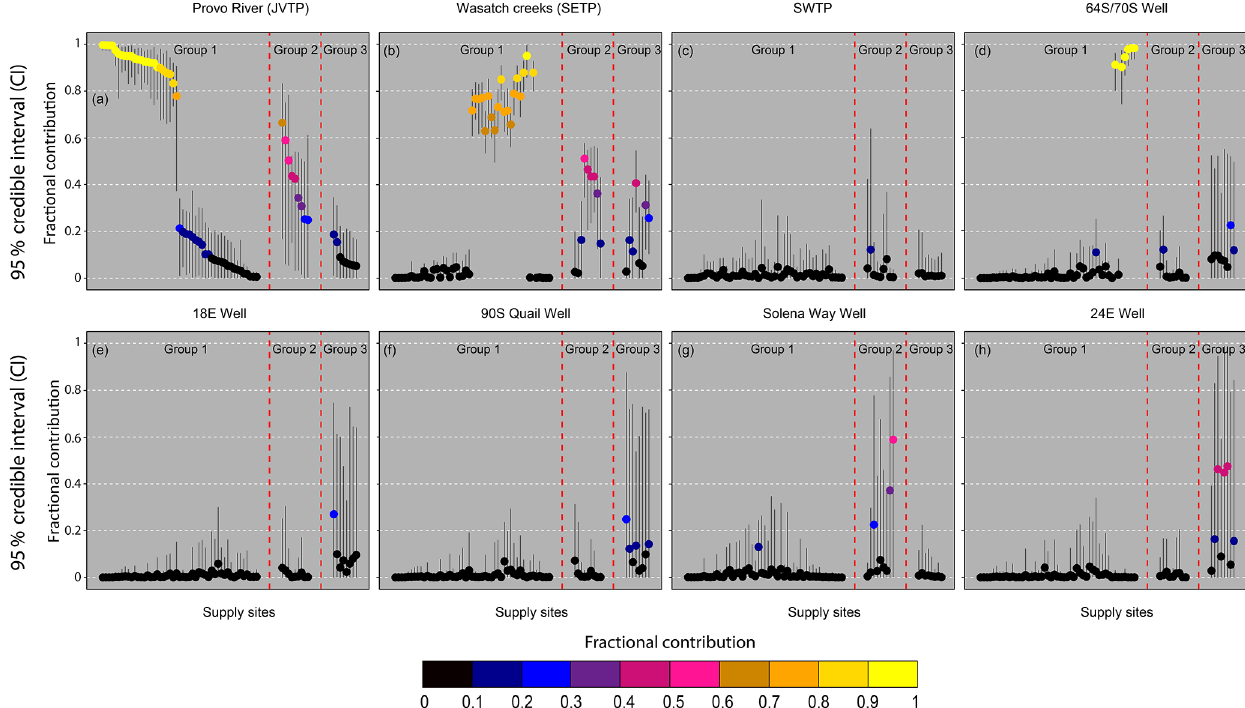
Figure 7. Mean (circle) and 95% credible interval (vertical black lines) associated with the source contributions at the distribution sites for the different groups for June 2015. Sites in (a) have been sorted with decreasing contribution from JVTP for each group. The same sorting order is maintained for (b–h)